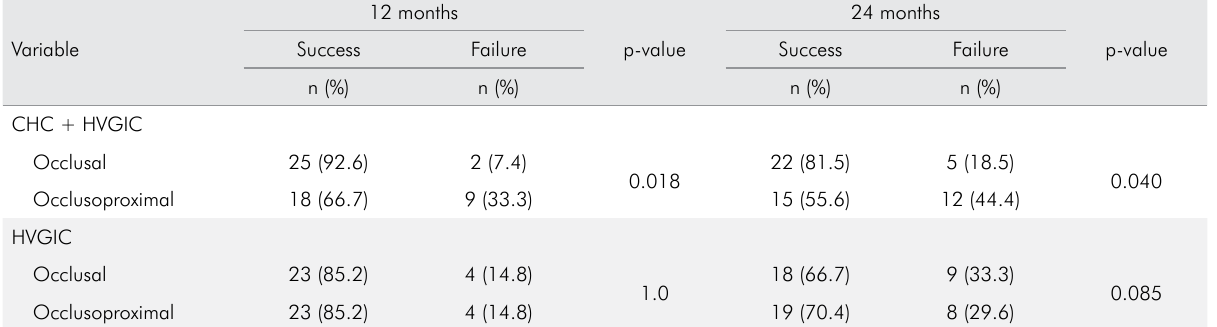
Table 3. Distribution of success and failure rate of pulp vitality according to the type of cavity at 12 and 24 months for both groups. Variable